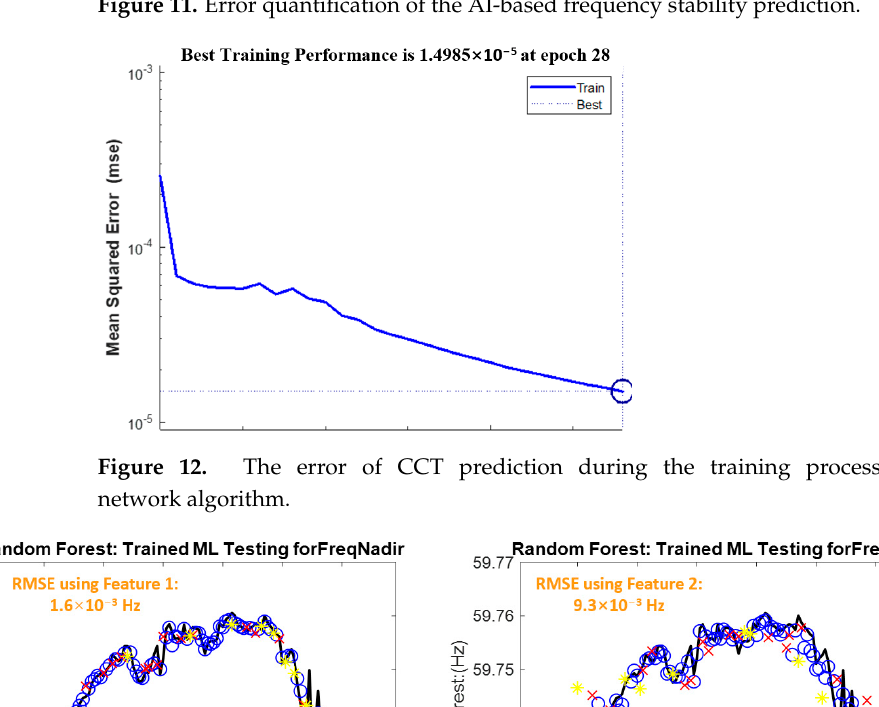
Figure 11. Error quantification of the AI-based frequency stability prediction.